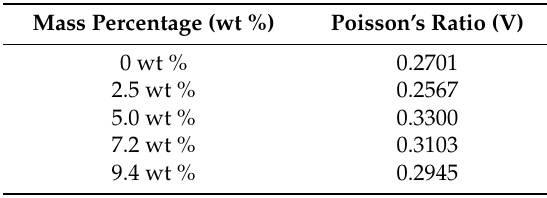
Table 1. Poisson’s ratio of five different composite models (average value).